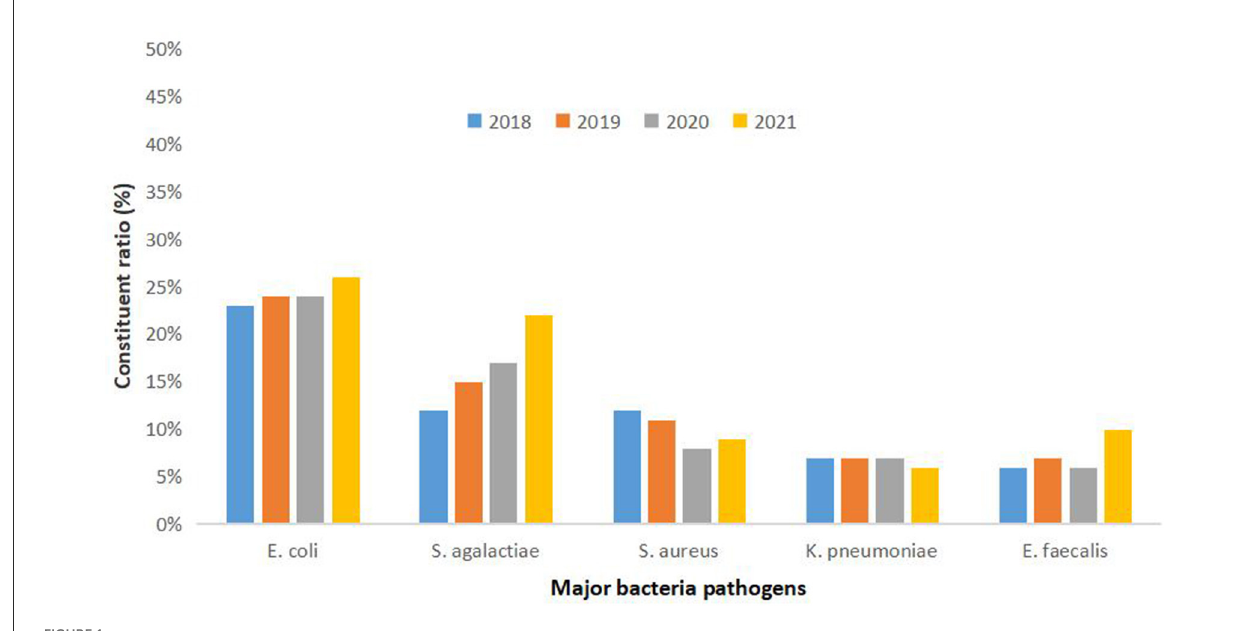
FIGURE1 Distribution of the most prevalent drug-resistant bacteria.